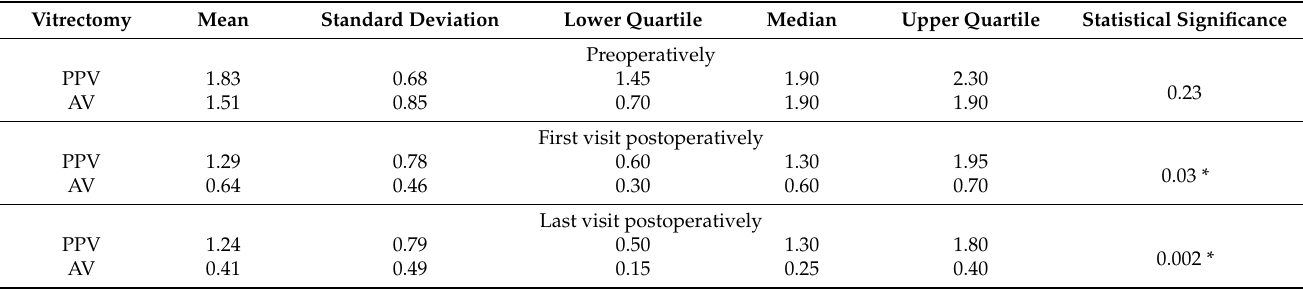
Table 3. Assessment of the visual acuity (logMAR) in both studied groups (anterior vitrectomy –AV and pars plana